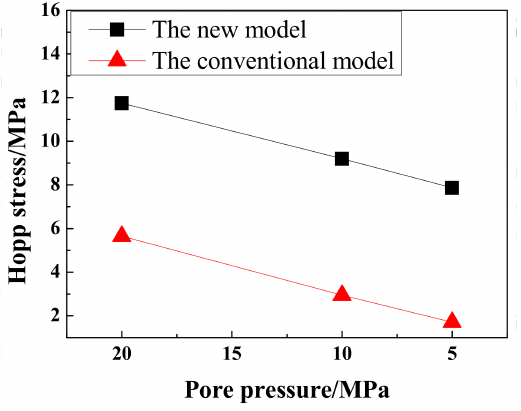
Figure 10. Hoop stress of cement sheath vs. pore